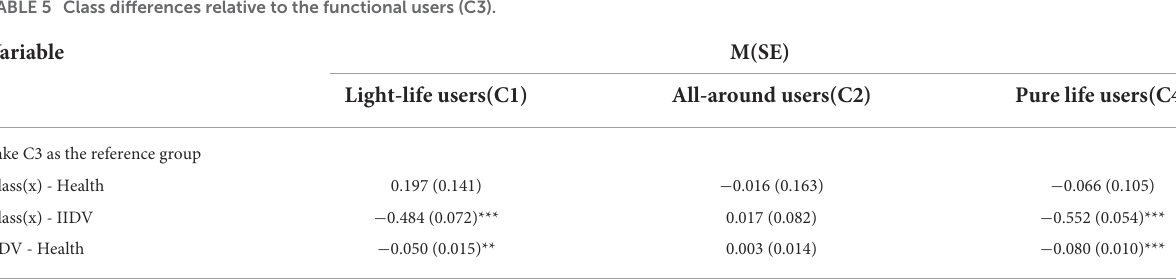
TABLE 5 Class differences relative to the functional users